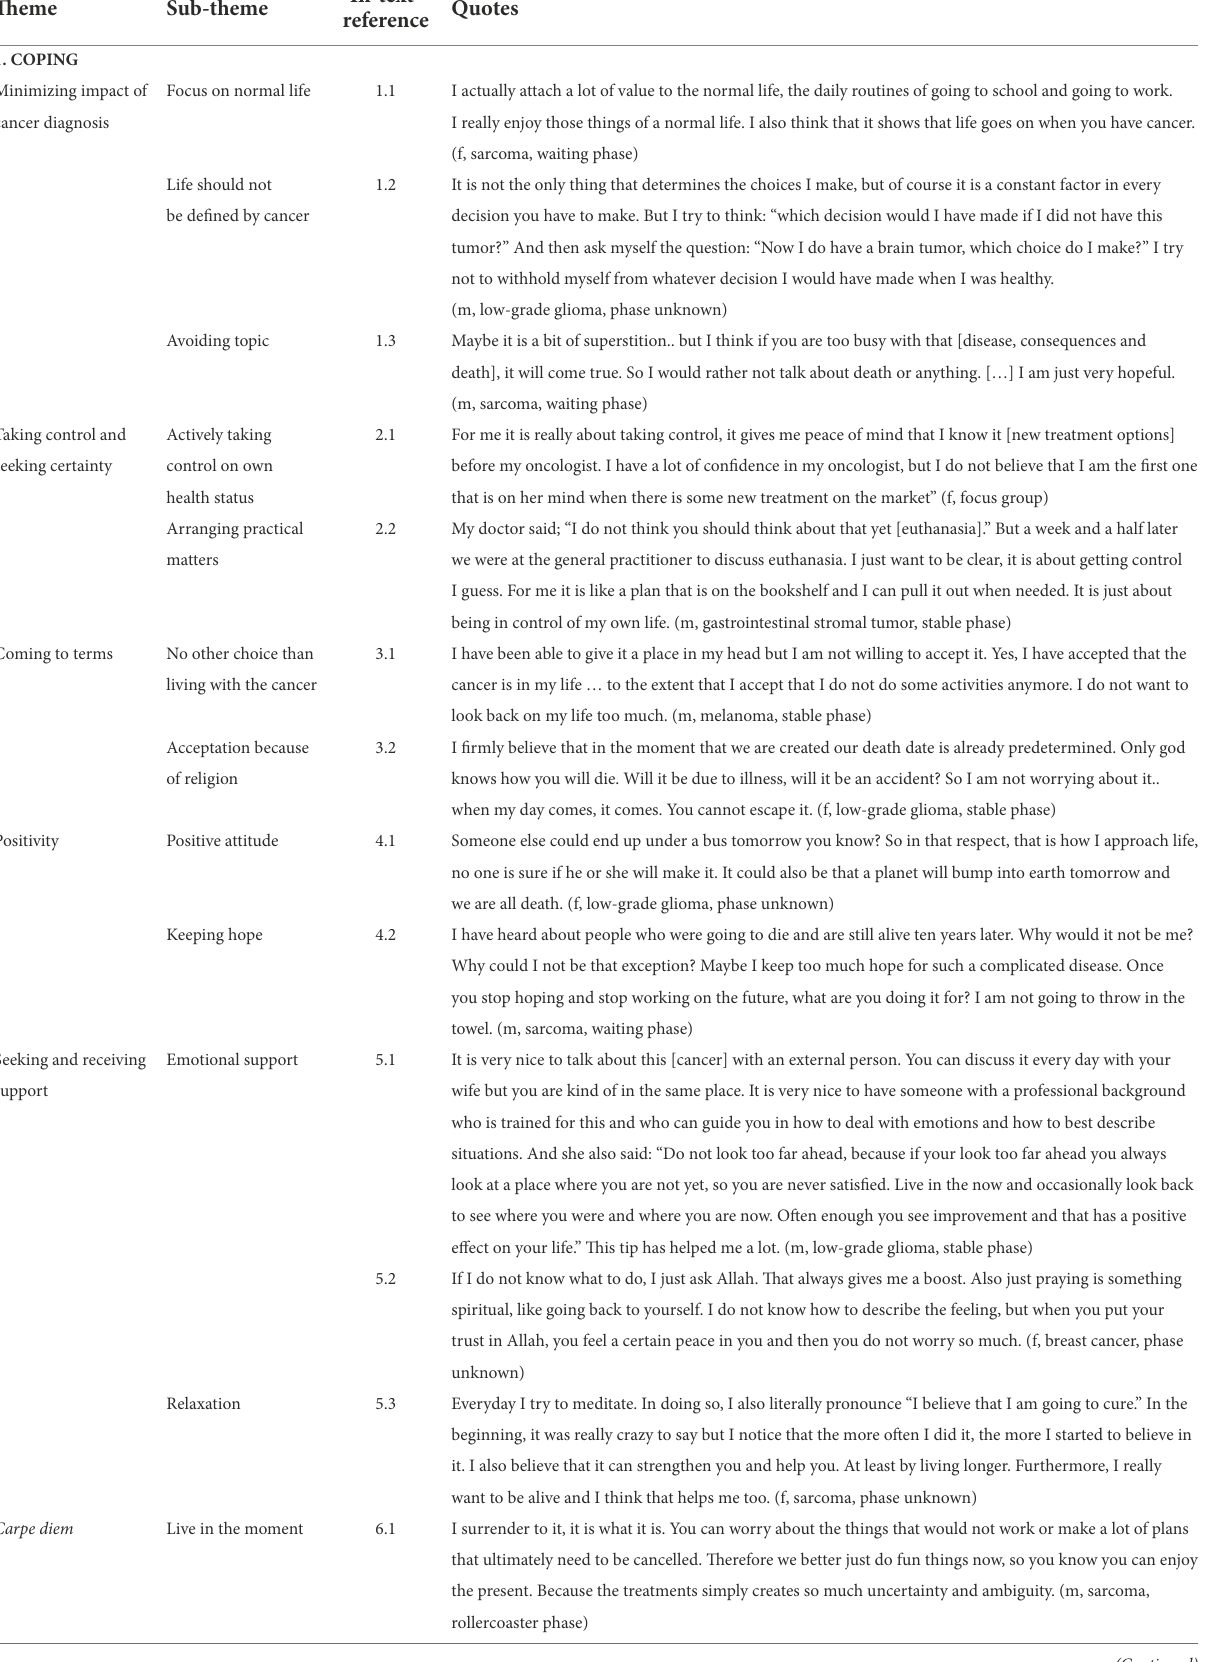
TABLE 3 Overview of themes, sub-themes and quotes of AYA interviews.